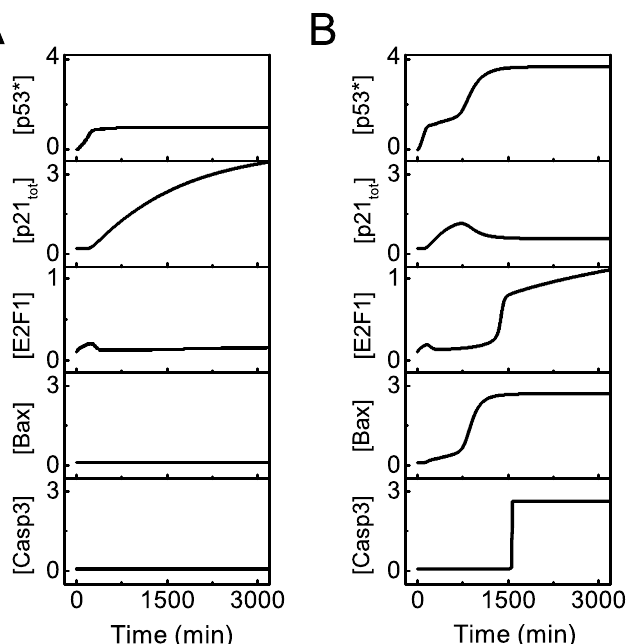
Figure 2. Overview of the dynamics of p53 signaling network. Temporal evolution of [p53 ∗ ], [p21 tot ], [E2F1], [Bax], and [Casp3] (from top to bottom) with DD = 25 ( A ) or 100 ( B ).